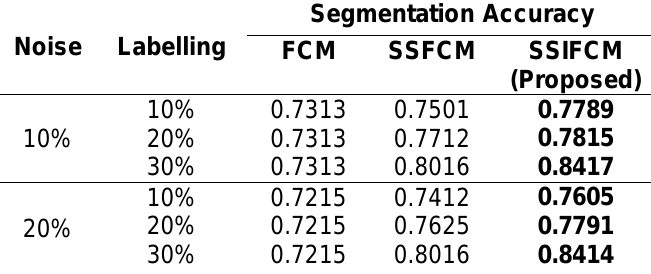
Table 7 . Comparative analysis of SSIFCM algorithm with FCM and SSFCM in terms of Segmentation